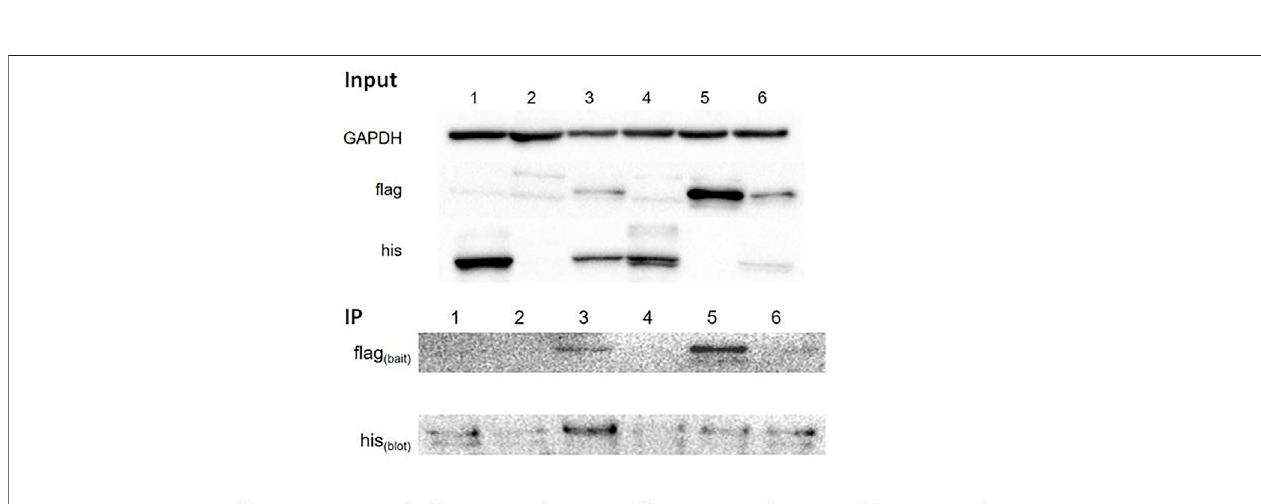
FIGURE4| ImmunoprecipitationassayoftheinteractionbetweenCPT2proteinwithUCP2protein.Resultsofaco-immunoprecipitationassaybetweentheCPT2- his and UCP2-fIag proteins. Immunoprecipitation with anti-FLAG beads coupled with Western blot analysis by histone antibody showed a strong physical interaction between CPT2 and UCP2. No obvious interacted signal was observed between mutant CPT2 and UCP2.